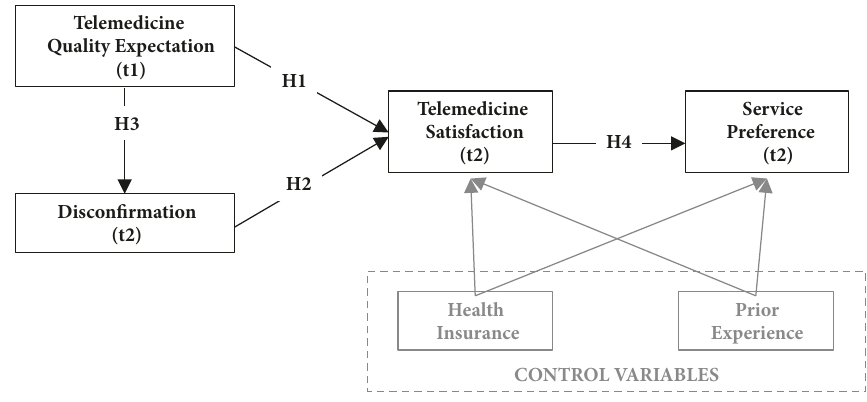
Figure 1: Research